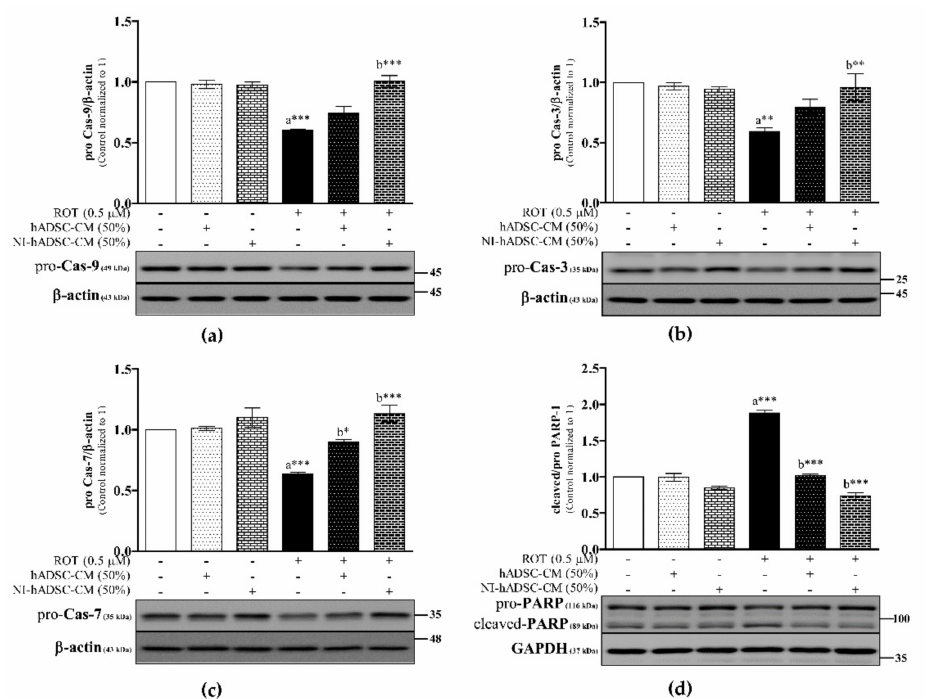
Figure 7. Effects of NI-hADSC-CM against ROT on caspases and PARP-1 protein expressions. SH-SY5Y cells were seeded at a density of 5 × 10 4 cells/mL in DMEM containing 1% FBS and used for experiments after overnight incubation. Cells in the absence or presence of ROT (0.5 µ M) for 48 h were treated with hADSC-CM (50%) or NI-hADSC-CM (50%) during the last 24 h, and the expression levels of pro-Cas-9 ( a ), pro-Cas-3 ( b ), pro-Cas-7 ( c ), PARP ( d ), and β -actin or GAPDH were assessed by Western blotting. Images are representative of three independent experiments. Data are presented as the mean ± SEM of three independent experiments. Statistical analysis was performed using one-way analysis of variance (ANOVA) followed by Tukey’s post hoc test. Statistical significance: a—compared with control; b—compared with ROT; * p < 0.05, ** p < 0.01, and *** p <